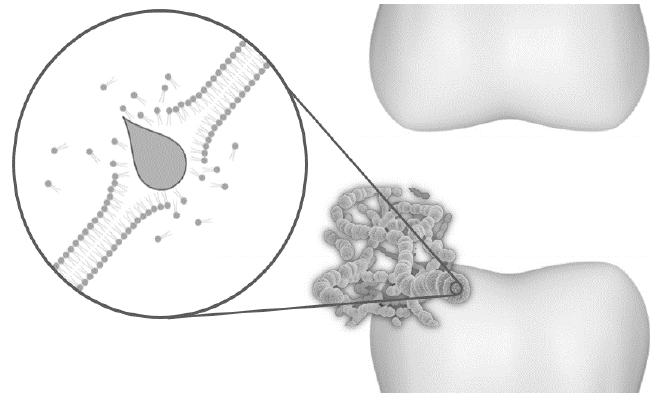
Figure 4. Hydrophobic molecules of the essential oils disintegrate the cytoplasmic membrane of S. mutans , causing the leakage of the cellular content and death.